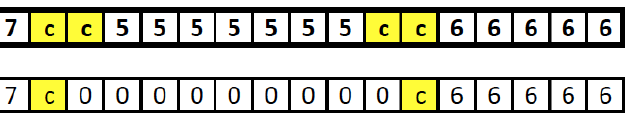
Figure 3. Examples of neighborhood definition 1.